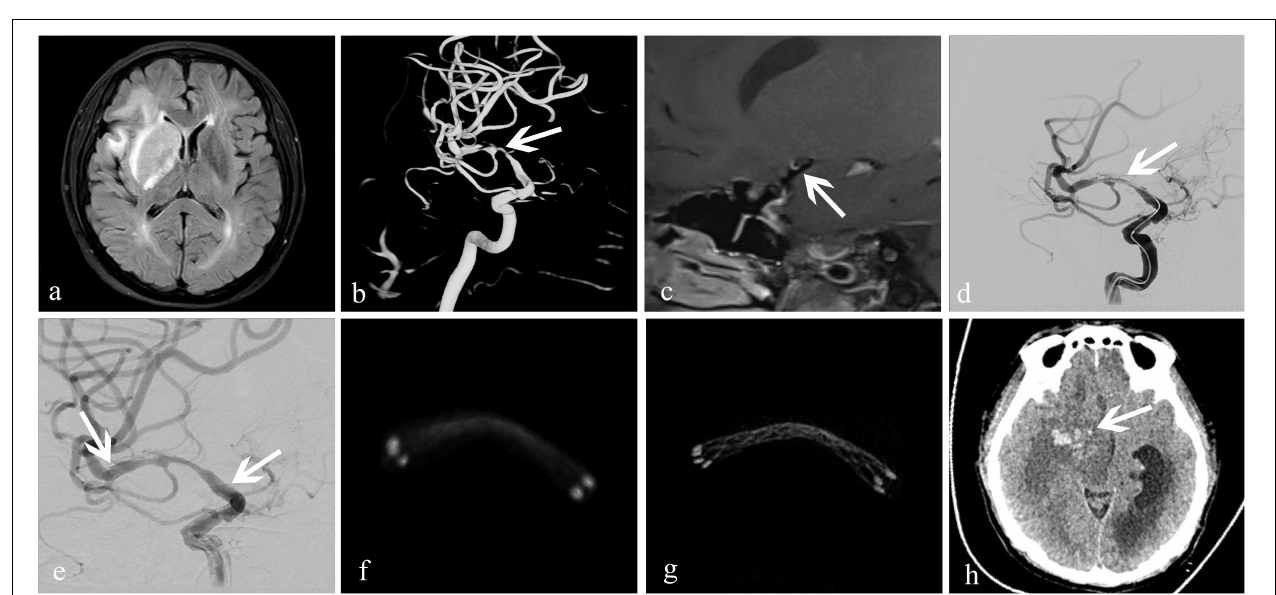
FIGURE 4 | Treatment of an atherosclerotic stenosis in the right middle cerebral artery with the EnterpriseTM stent. A 52-year-old woman who presented with left-limb weakness of 12-day duration. (a) MRI showed subacute cerebral infarction in the right temporal lobe and basal ganglia; (b) 3D-DSA revealed severe stenosis (83%) at the bifurcation of the right middle cerebral artery (white arrow); (c) high-resolution MRI showed that the stenosis was atherosclerotic (white arrow); (d,e) dilation using a GatewayTM balloon was done followed by insertion of an Enterprise stent measuring 4.5 mm × 22 mm (white arrow). Residual stenosis was 28%; the two arrows in (e) showed both ends of the stent. (f) conventional FDCT showed a good position of the distal and proximal stent markers, but the stent itself was poorly visualized with an image-quality score of 0; (g) HR-FDCT showed good deployment of the stent, and the image quality was improved significantly with a score of 2; (h) 6-h later, CT of the head showed cerebral parenchymal hemorrhage (white arrow) in the former infarction area at right basal ganglia.